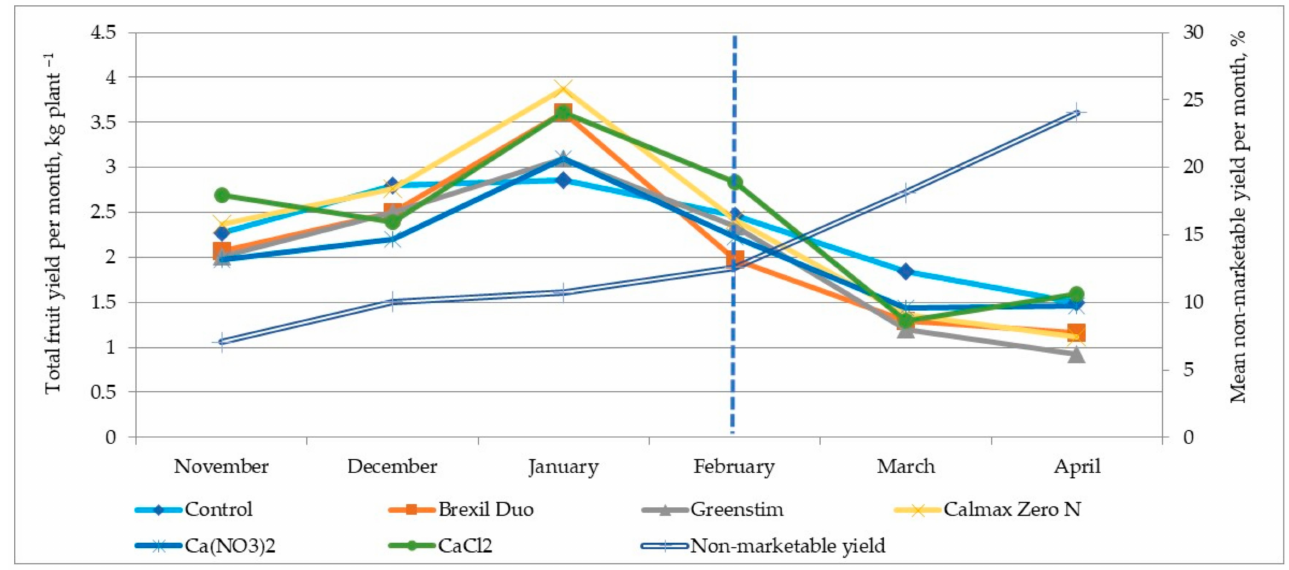
Figure 3. Total yield (kg plant − 1 ) and mean non-marketable ‘Beorange’ tomato yield (% of total) per month in a greenhouse experiment with a spraying of different Ca-containing/Ca uptake-promoting preparations in the 2020/2021 season. The dashed vertical line indicates the end of February 2021, and a decrease in fruit Ca concentration.